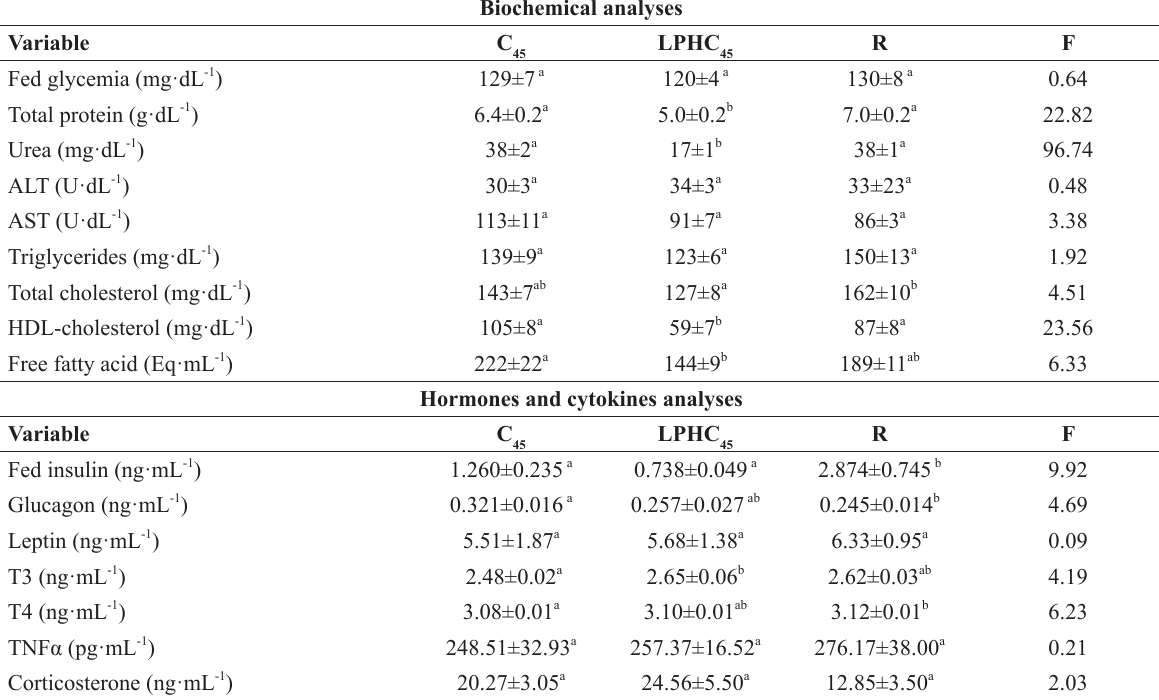
, LPHC , and R rats.* 45 45